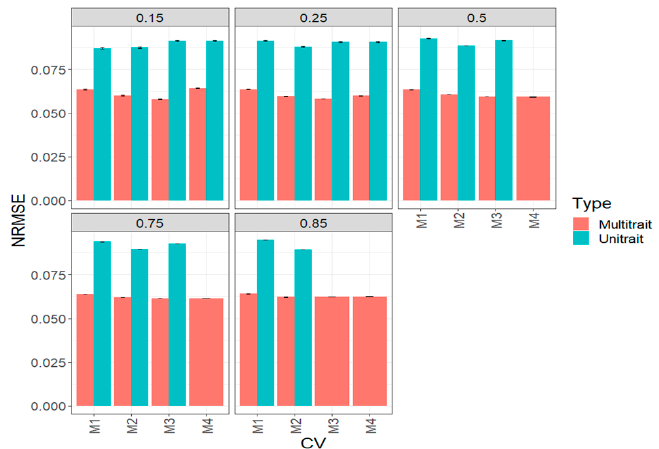
Figure 5. Prediction performance for the complete wheat data set in terms of normalized root mean square error (NRMSE) of the four methods of sparse testing (M1, M2, M3 and M4) under unit-trait and multi-trait models for 5 percentages of testing: 15% (0.1), 25% (0.25), 50% (0.5), 75% (0.75) and 85% (0.85).